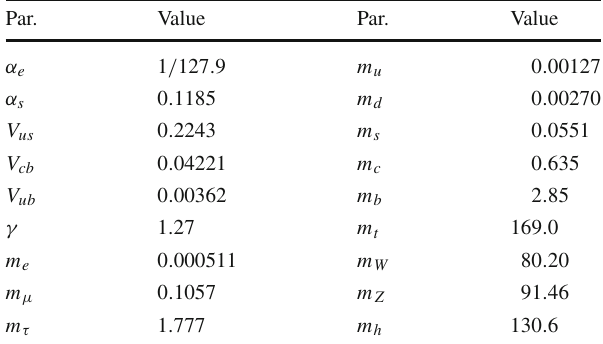
Table 1 SM MS parameters at the scale M Z . Masses are given in units of GeV Par. Value